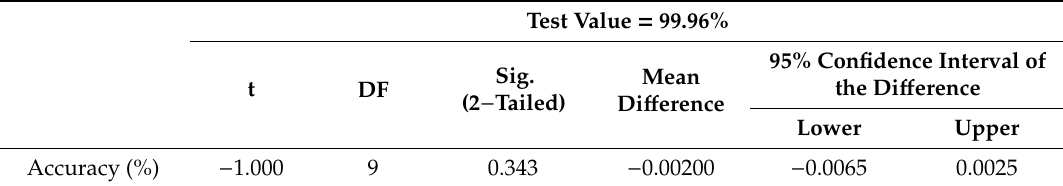
Table 15. One-sample t-test results for the accuracy of Mirai, Bashlite, and benign classification using a 10-fold cross-validation